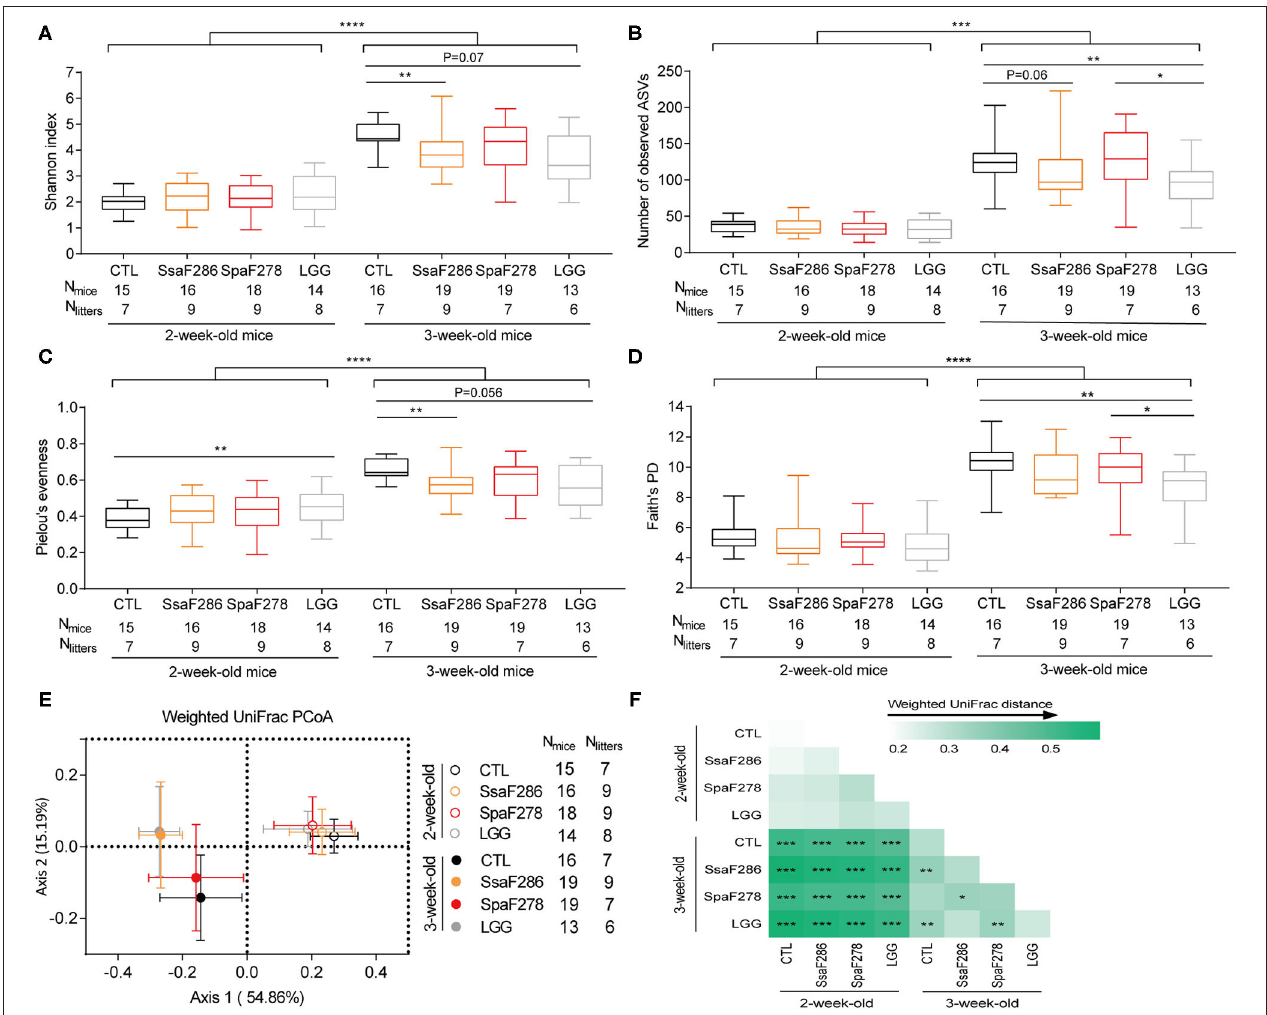
FIGURE 2 | S. salivarius F286 and LGG reduced the α -diversity and changed the β -diversity of the colonic microbiota of 3-week-old pups. (A) Shannon index. (B) Number of observed ASVs. (C) Pielou’s evenness index. (D) Phylogenetic diversity (PD) based on Faith’s approach. In the box plot, the bottom and top are the 25th and 75th percentiles, respectively, and a line within the box marks the median. Whiskers above and below the box indicate min to max. The values of different animal groups were compared with the Mann–Whitney test. * p < 0.05; ** p < 0.01; *** p < 0.001; **** p < 0.0001. (E) PCoA plot based on weighted UniFrac distance of colonic microbiota of 2- and 3-week-old pups of different groups. (F) Heatmap of the weighted UniFrac distances between each two groups and permutational multivariate analysis of variance (PERMANOVA; 9,999 permutations). * p < 0.05; ** p < 0.01; *** p < 0.001. CTL, Control group; SsaF286, S. salivarius F286 group; SpaF278, S. parasanguinis F278 group; LGG, LGG